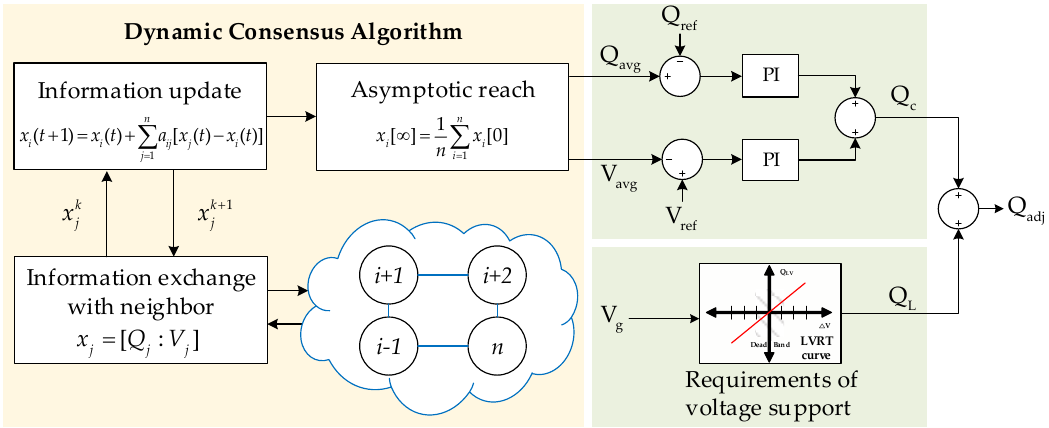
Figure 5. Control diagram of the secondary control layer.